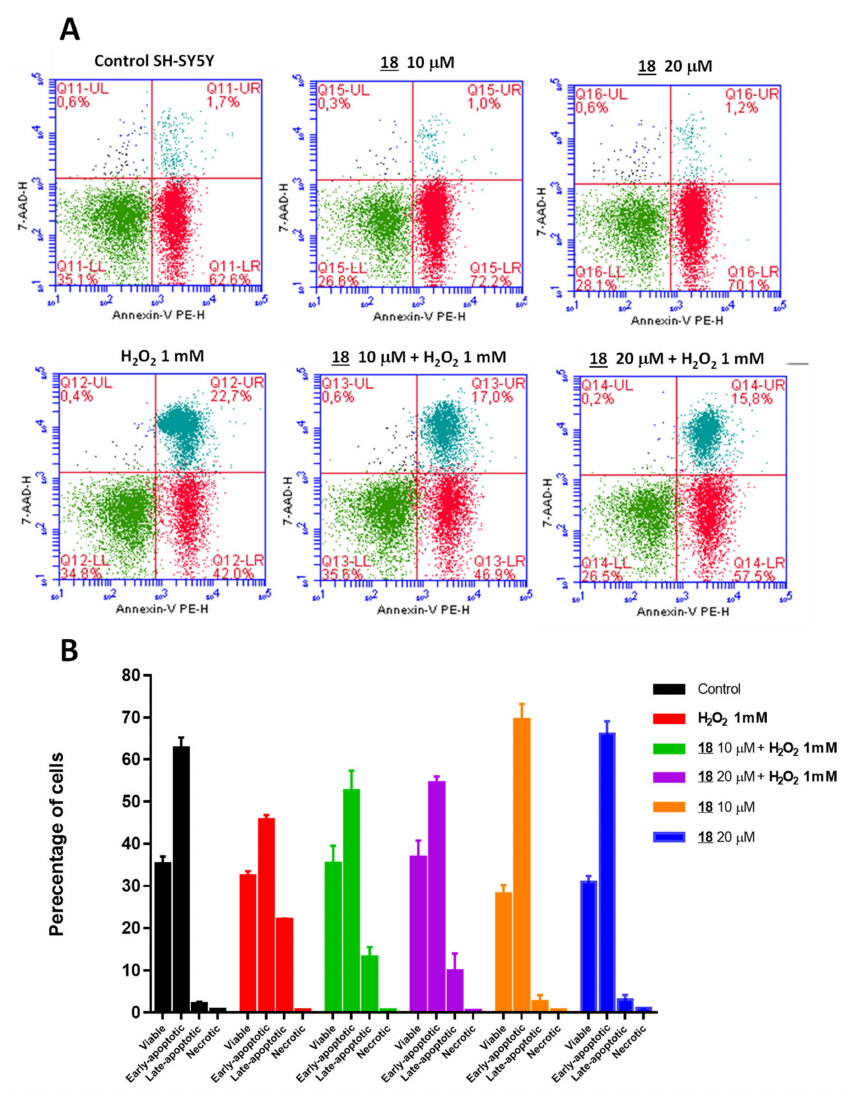
Figure 21. Results from apoptosis and necrosis flow cytometry experiments with Annexin V-PE and 7-AAD. ( A ) Dot plots for each compound treatment where quadrants indicate the cell population’s distribution for each sample. SH-SY5Y cells were treated with 18 at 0, 10, and 20 µ M for 24 h at 37 ◦ and then exposed to H 2 O 2 1 mM for 4 h. Q1-LL: viable cells; Q1-LR: early apoptotic cells; Q1-UR: late apoptotic cells; Q1-UL: necrotic cells. ( B ) Histogram representation of the percentage of each cell population for each compound treatment. Data are the Mean ± SD of four independent